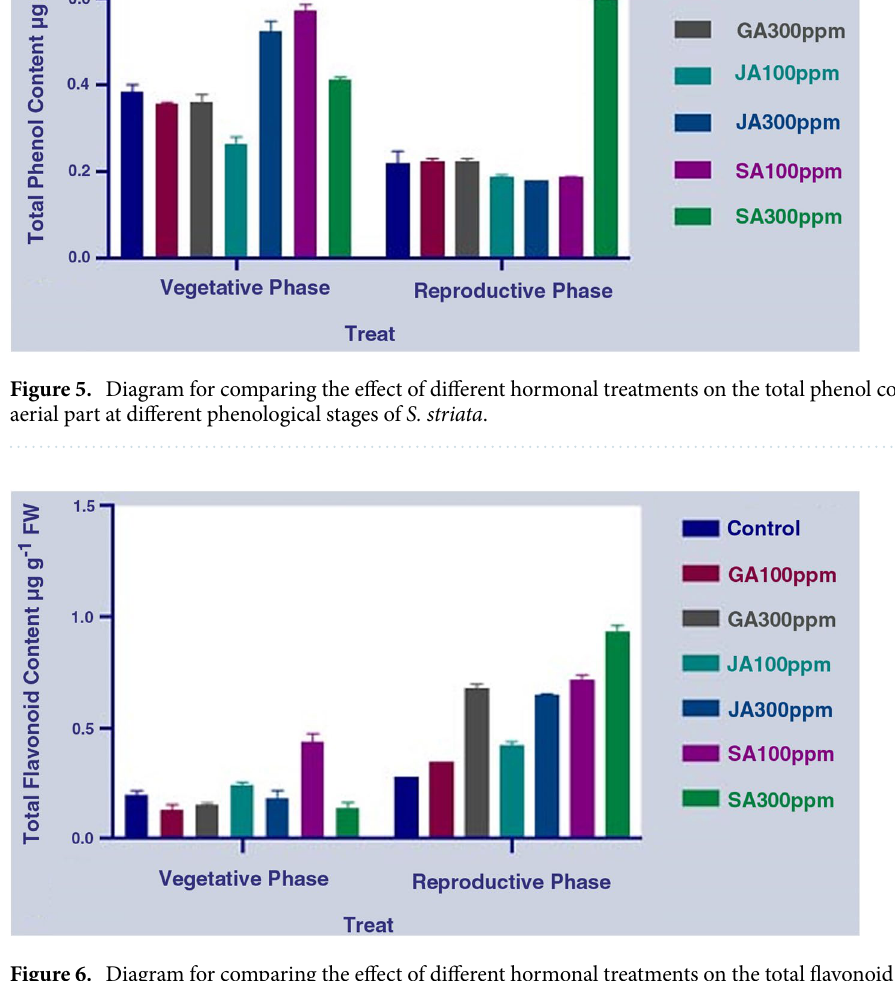
Figure 6. Diagram for comparing the effect of different hormonal treatments on the total flavonoid content in the aerial part at different phenological stages of S. striata.